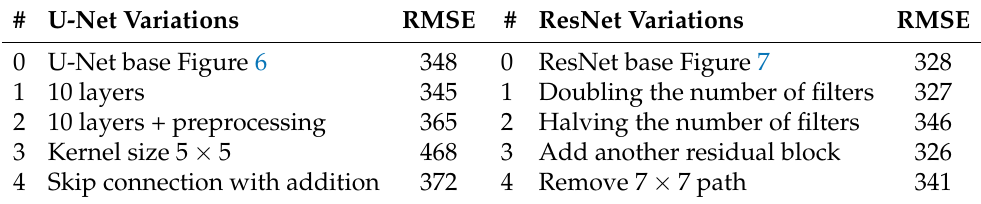
Table 3. Variations in terms of layers, kernel size and skip connections for the U-Net architecture (first column) and variations in terms of number of filters, number of residual blocks and number of paths for the ResNet architecture (second column). The row marked with ‘0’ indicates the base architecture on which the variations are applied. The RMSE is included for each